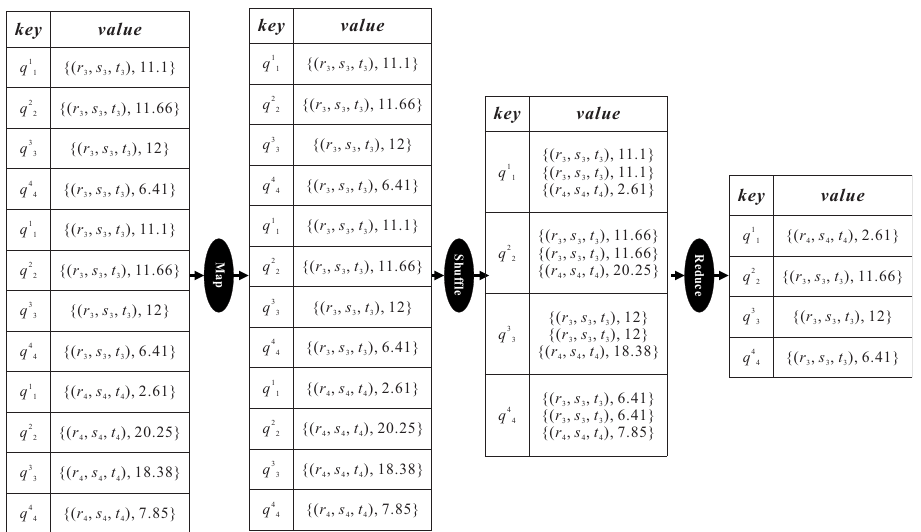
Figure 7. Illustration of the Result set generating